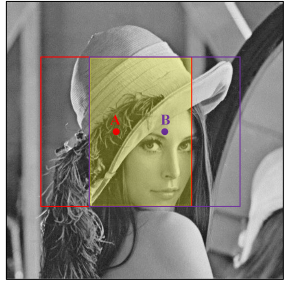
Figure 4. Full field whole pixel displacement vector.